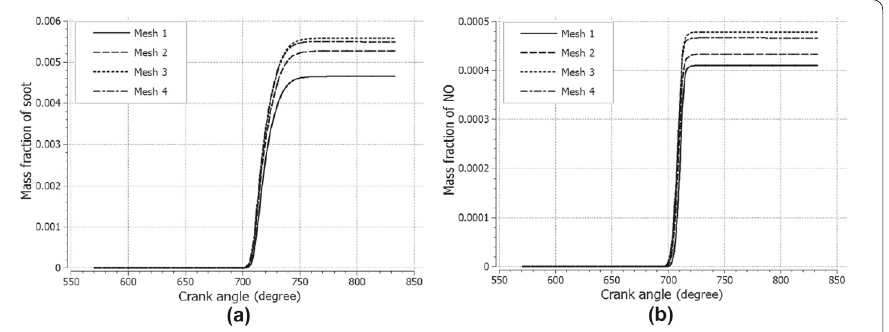
Fig. 3 a Soot mass fraction b NO mass fraction for four different mesh